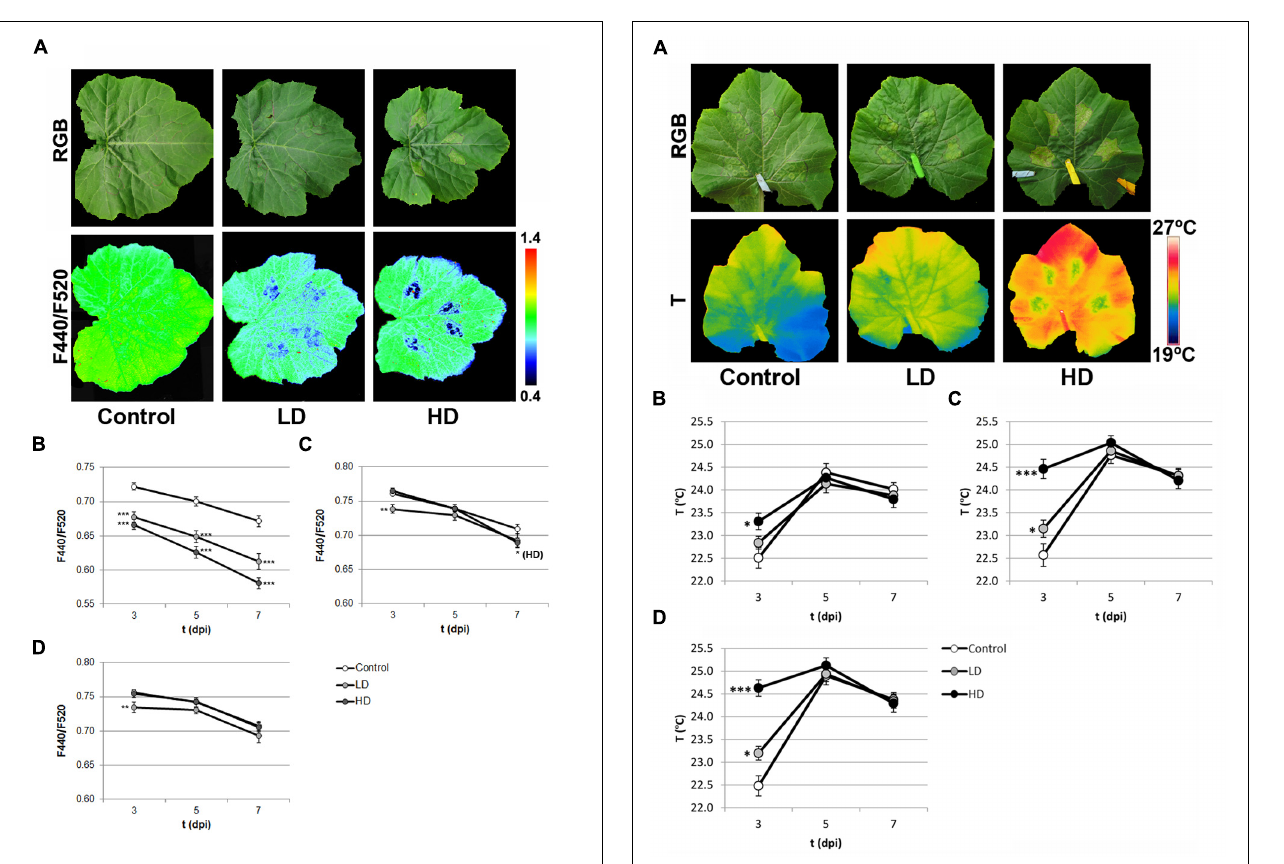
FIGURE 3 | (A) Standard thermal images of mock-control, LD, and HD-inoculated zucchini leaves at 3 dpi, and their corresponding RGB images. (B) Evolution of temperature in I (B) , N (C) , and D (D) areas of the leaves along the period of study. Symbols ∗ and ∗∗∗ stand for p < 0.1 and 0.001,